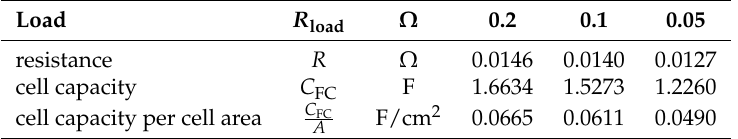
Table 3. Calculated values for double layer capacity and short circuit